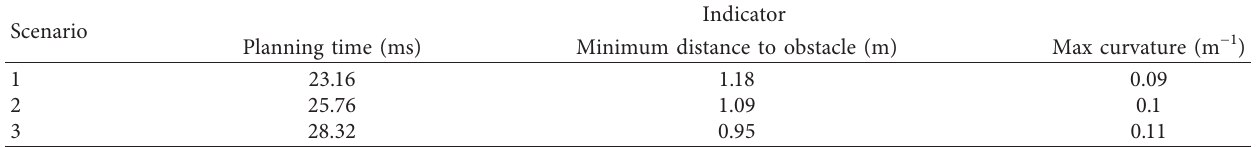
Table 3: The main evaluation indicators of path planning results in high-level model.